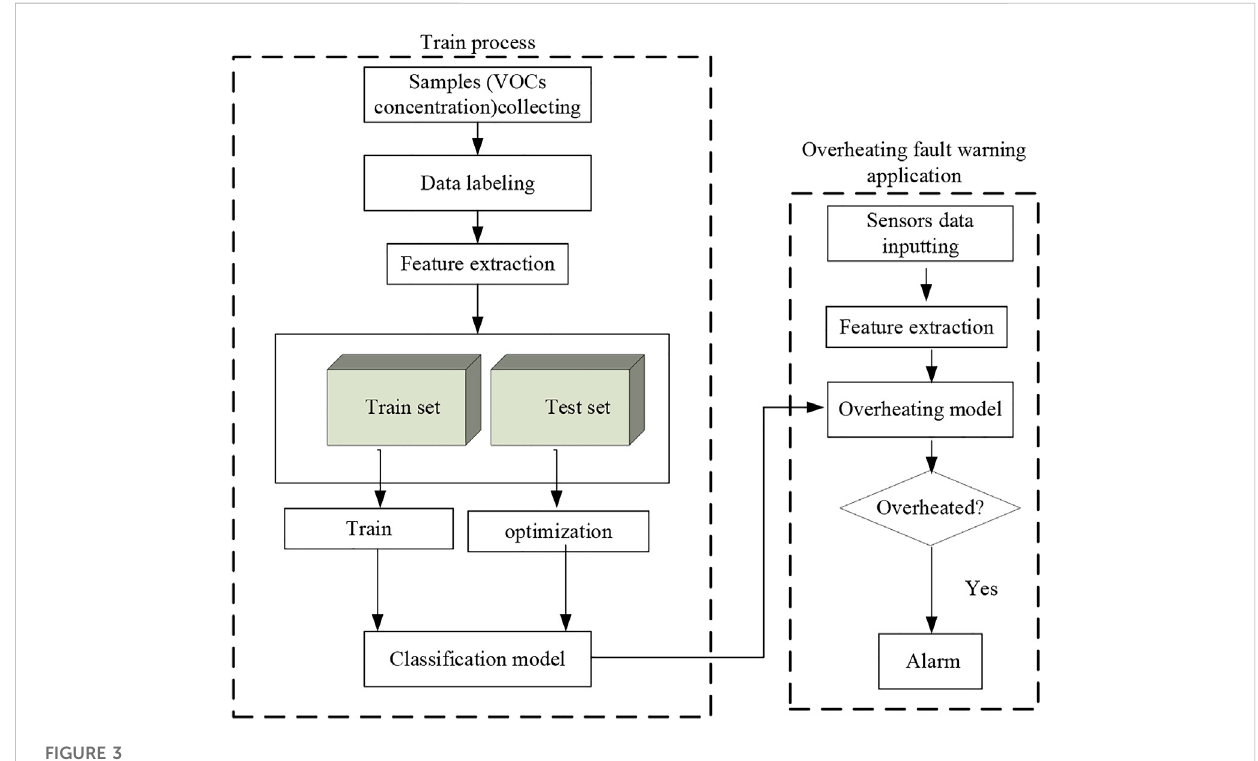
FIGURE 3 System